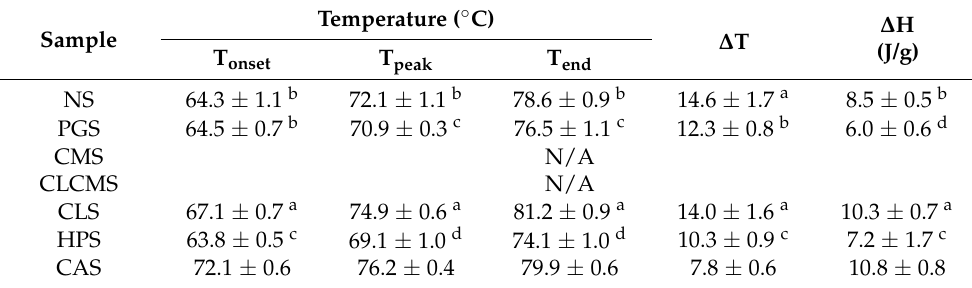
Table 3. Thermal Properties of Native and Modified KJ CMU-107 Rice Starches.